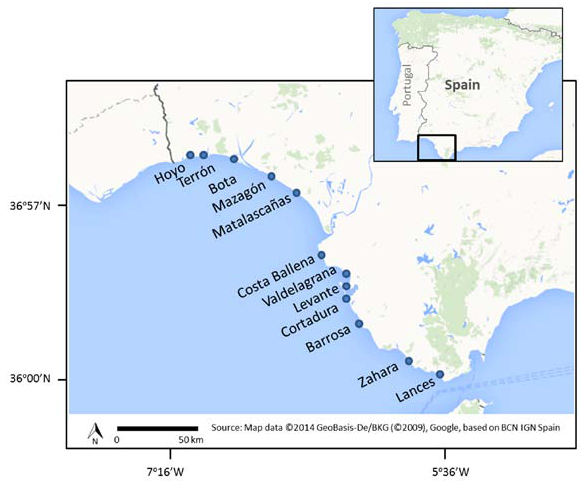
Fig. 1. – Study area showing the 12 sandy beaches